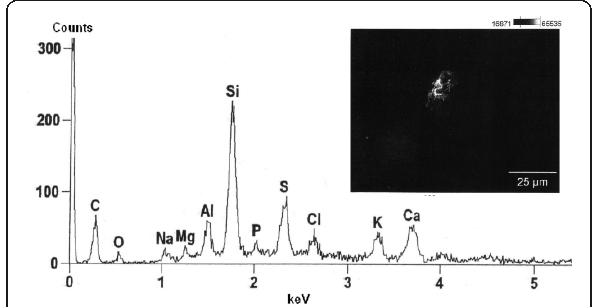
Figure 3 Energy dispersive x-ray spectroscopy showing Silicon as major element (Xaxis: Energy of detected x-ray quanta in keV; Y-axis: Signal-intensity in counted x-ray quanta; Elements corresponding to the intensity-peaks indicated by there element symbols)